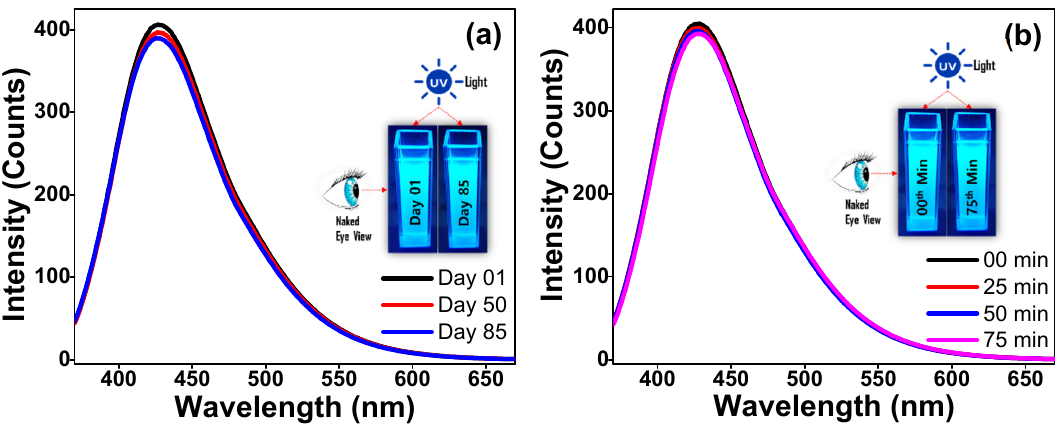
Figure 5. ( a ) Fluorescence emission spectra at different storage times and ( b ) Fluorescence emission spectra at different irradiation times of the synthesized hydrophilic O -CDs (insets: O -CD aqueous solution under the illumination of 365 nm UV light at different storage time and irradiation time).